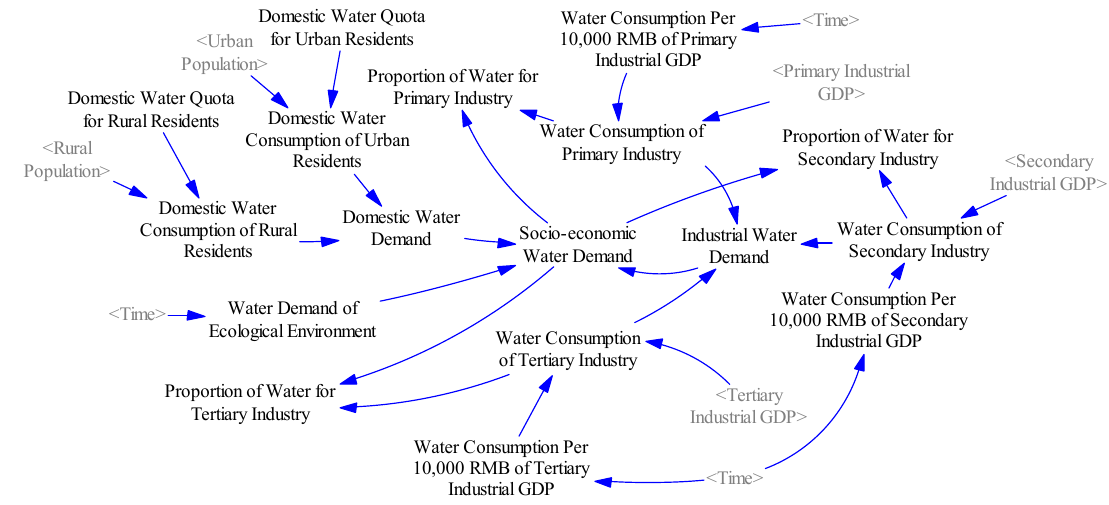
Figure 3. System dynamics flowchart of the water resource demand subsystem.